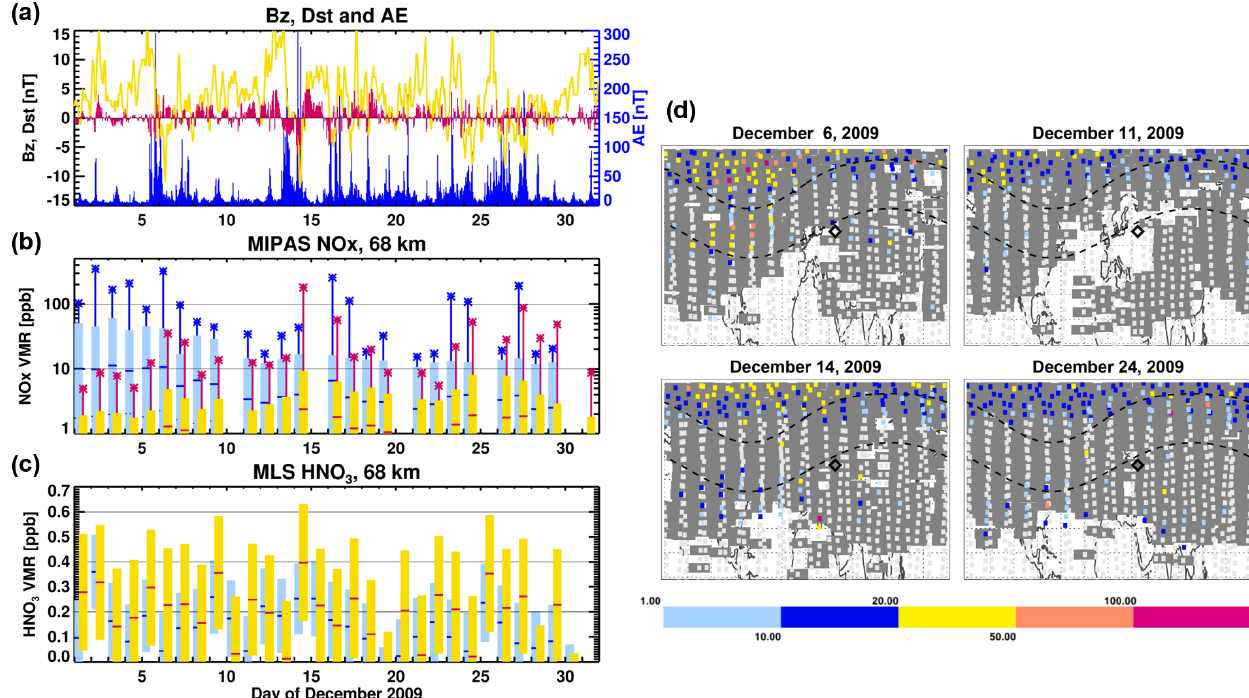
Figure 5. (a) Bz (red), Dst index (yellow) and AE index (blue). (b) MIPAS NO x (NO + NO 2 ) at 68km altitude at high latitudes (50–81 ◦ N; blue) and at geomagnetic midlatitudes (10–55 ◦ geomagnetic latitude; red). Horizontal line segments mark the mean values, the error bars are the 95% percentile, and the stars are the maximal values of the day. (c) MLS HNO 3 at 68km altitude at high latitudes (50–81 ◦ N; blue) and at geomagnetic midlatitudes (10–55 ◦ geomagnetic latitude; red). Horizontal line segments mark the mean values and the error bars the 2 σ standard error of the mean. (d) MIPAS NO x on the satellite overpass footprints on 4d (6, 11, 14 and 23 December) at 68km altitude in the Northern Hemisphere. The dashed lines mark geomagnetic latitudes of 50 and 75 ◦ . The diamonds mark the position of Moscow. Colored symbols mark observations larger than the monthly mean plus one standard error. Dark gray areas mark MIPAS footprints, where carbon monoxide CO at 70km is larger than 1.5ppm (parts per